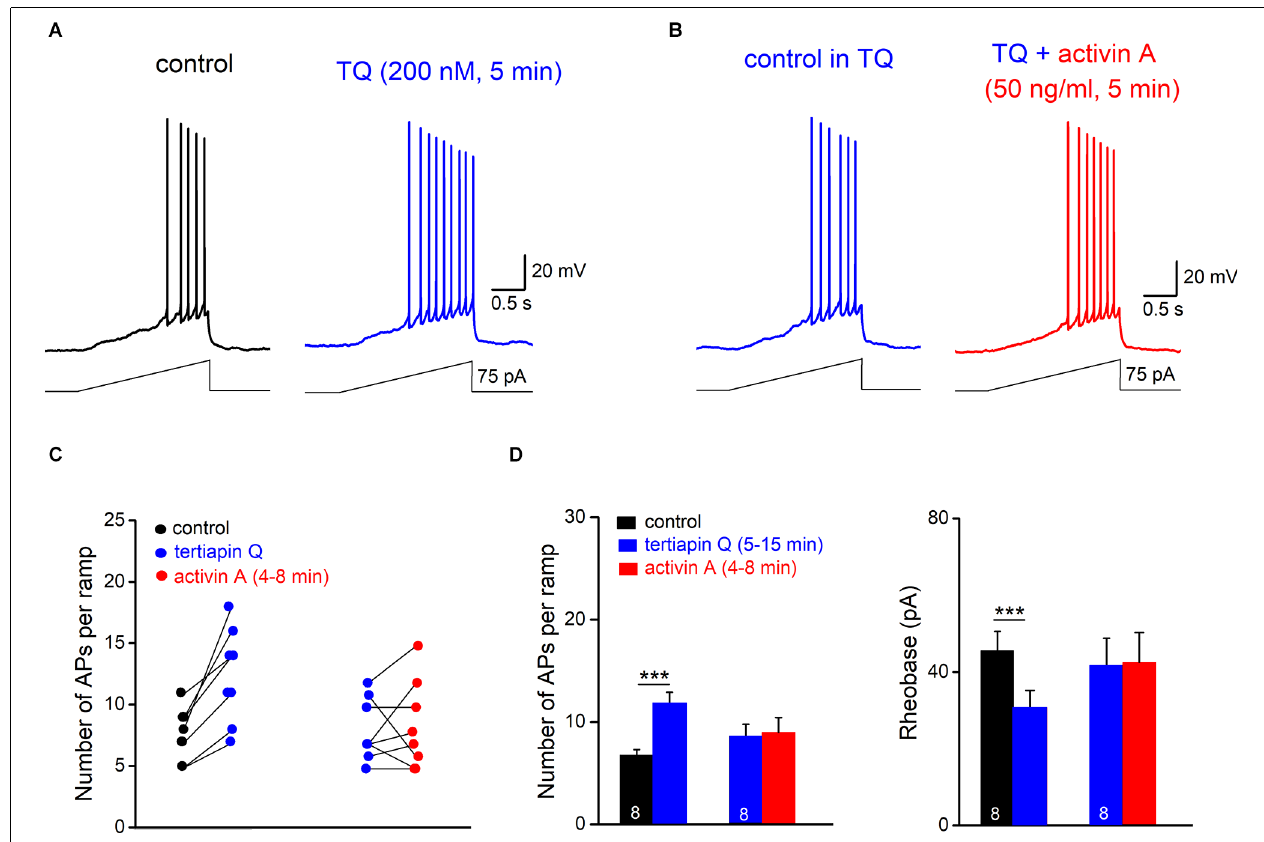
FIGURE 5 | GIRK channel inhibition occludes excitatory effect of activin on granule cell firing. (A,B) Tertiapin Q (TQ) alone enhanced ramp-evoked firing (A) and precluded further excitation by activin A (B) . Note that in (B) the control trace with TQ (15 min) was reset to -70 mV before activin A was applied. (C) Plots of individual granule cell responses to TQ alone and with activin A added later. (D) Histograms summarize the abrogation of characteristic effects of activin A on hippocampal granule cell firing and rheobase by TQ. *** p <